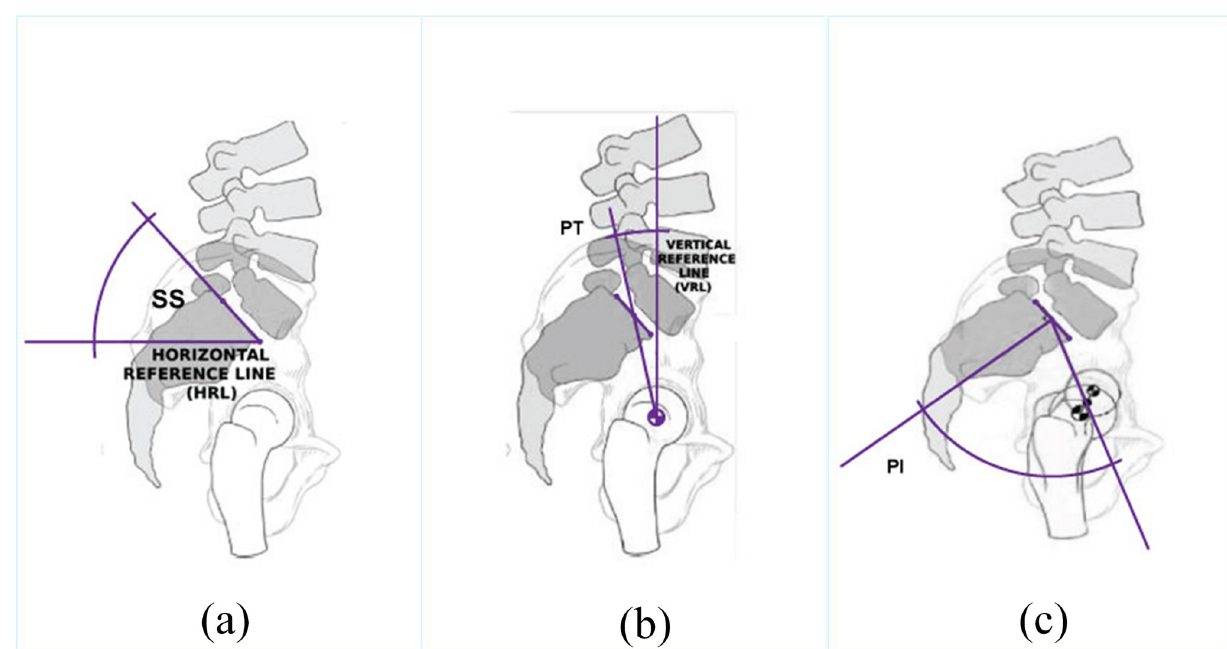
Fig 1. Illustration of a spino-pelvic system (a) pelvic tilt (PT) (b) pelvic incidence (PI) (c) sacral slope (SS) [3].